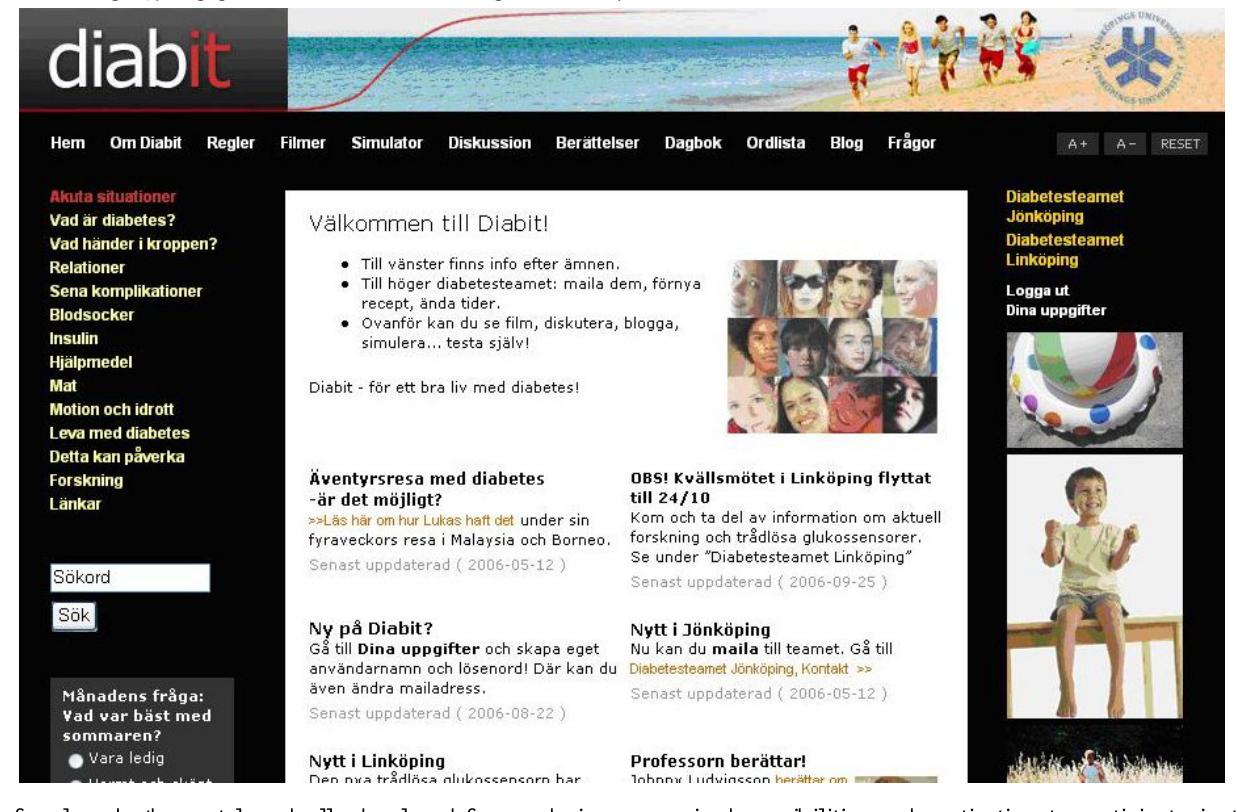
Figure 1. Screenshot of the portal displaying links for specific diabetes information (left); local diabetes team services, news, and personalized information (right); pedagogic devices and social networking functions